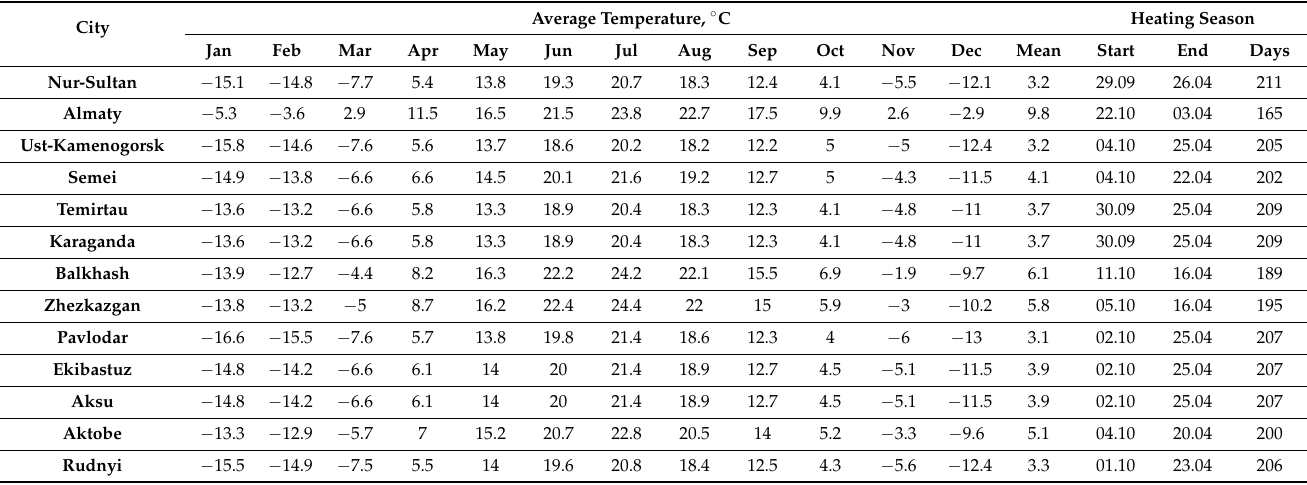
Table A2. Monthly average temperature and duration of the heating season by selected cities (Source: adapted from State standards in the field of architecture, urban planning and construction, 2017 https://igis.kz/images/snip/stroitelnye- normativy/sp-rk-2.04-01-2017-stroitelnaya-klimatologiya.pdf (accessed on 20 February 2021)).